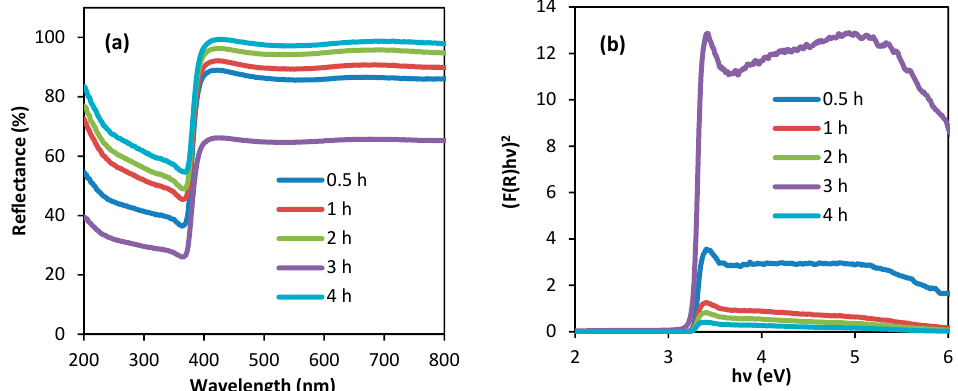
Figure 6. ( a ) Diffuse reflectance UV–visible spectra of Ag/ZnO and ( b ) Tauc plot of [F(R)h ν ] 2 versus photon energy at different calcination times.